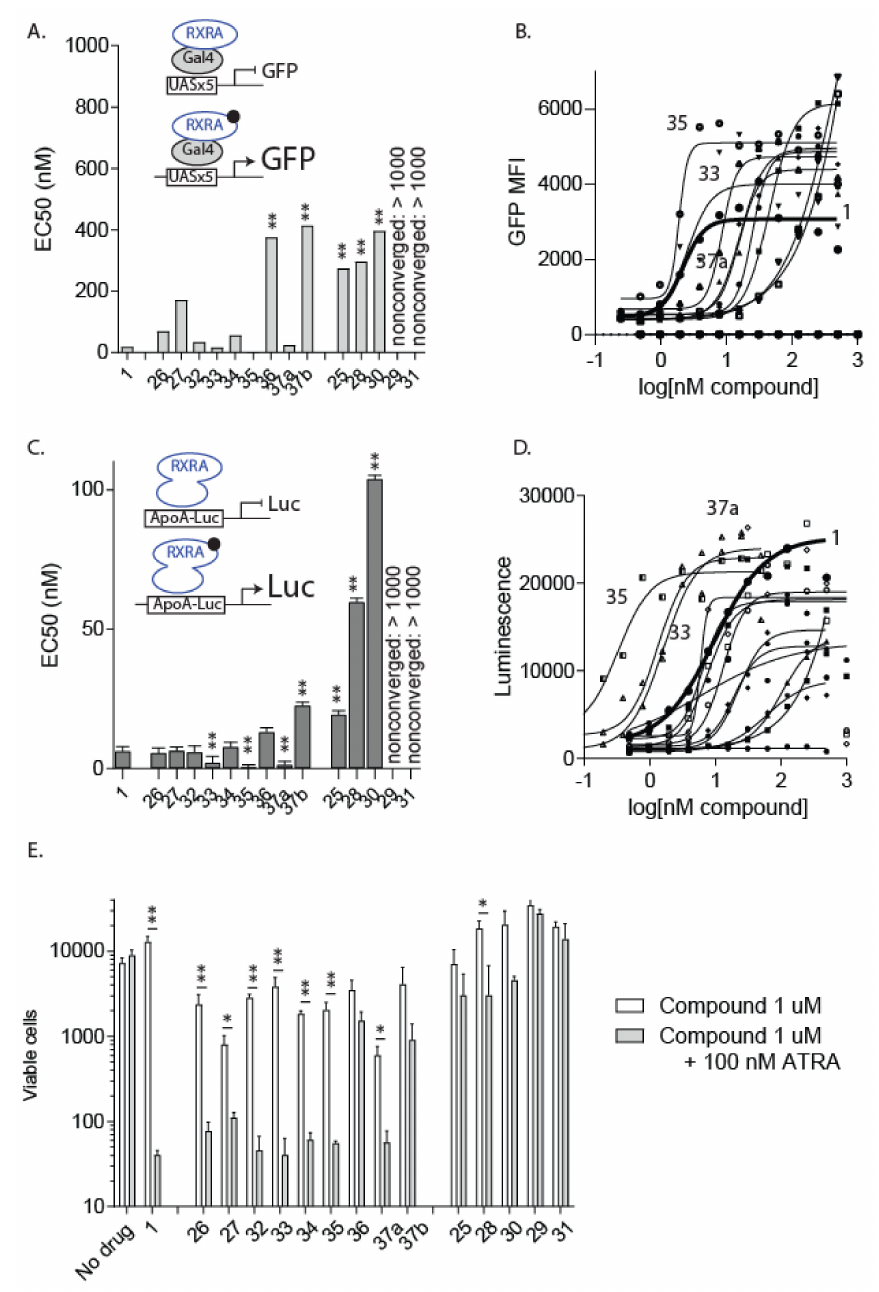
Figure 7. Effect of pharmacological targeting of RXRA on KMT2A-MLLT3 proliferation in vitro. ( A ) EC 50 (nM) values for each compound were calculated based on the ratio of GFP+ mCherry+ cells to total mCherry+ cells in UAS-GFP × KMT2A-MLLT3 cells transduced with Gal4-RXRA retrovirus and treated as indicated. ** p < 0.01 compared with 1 (bexarotene) result. ( B ) GFP activation used to calculate EC 50 in ( A ), each dose evaluated in duplicate. ( C ) EC 50 (nM) values for each compound were calculated based on the luciferase relative intensity of 293T cells transduced with pBABE-RXRA and ApoA1-Luc and treated as indicated. * p < 0.05, ** p < 0.01 compared with 1 (bexarotene) result. ( D ) Luciferase luminescence results used to calculate EC 50 in ( C ), each dose evaluated in duplicate. ( E ) UAS-GFP x KMT2A-MLLT3 cells were treated as indicated, replated after 48 h, and total viable cells in 50 µ L assessed in duplicate after 96 total hours of treatment. ** p < 0.01 comparing results with and without ATRA (all trans retinoic acid) treatment. Pairwise